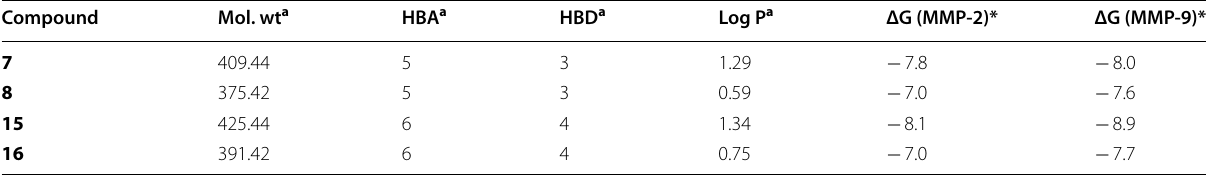
Table 2 Docking scores and molecular properties of selected compounds